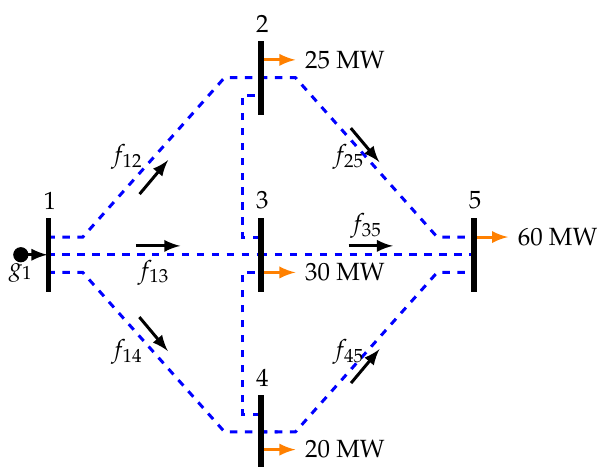
Figure 1. Small transmission system for the illustrative